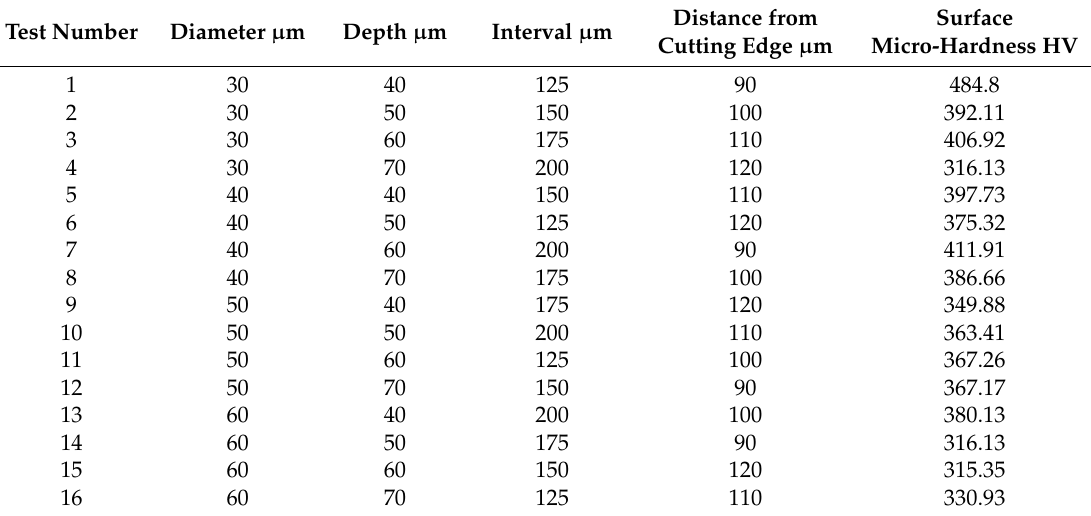
Table 6. Surface-hardness test data and test Table 6. Surface ‐ hardness test data and test results.